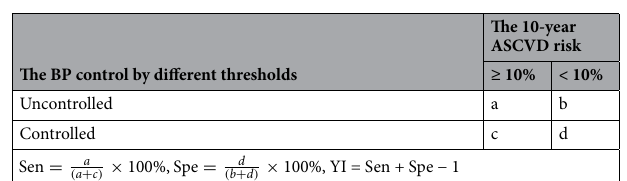
The BP control by different thresholds